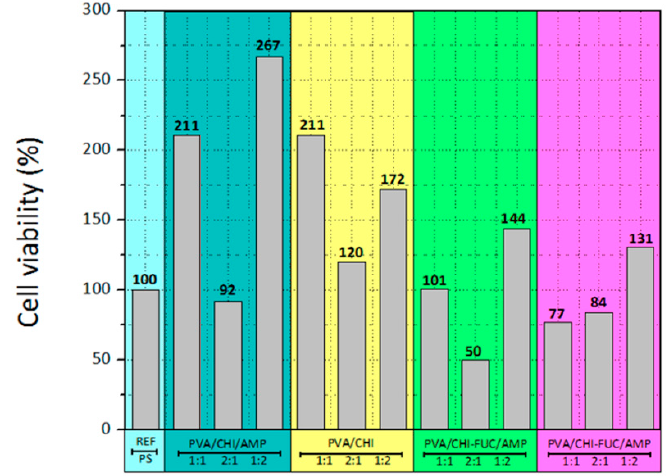
Figure 4. Cell viability of the BAPM (MTT assay).